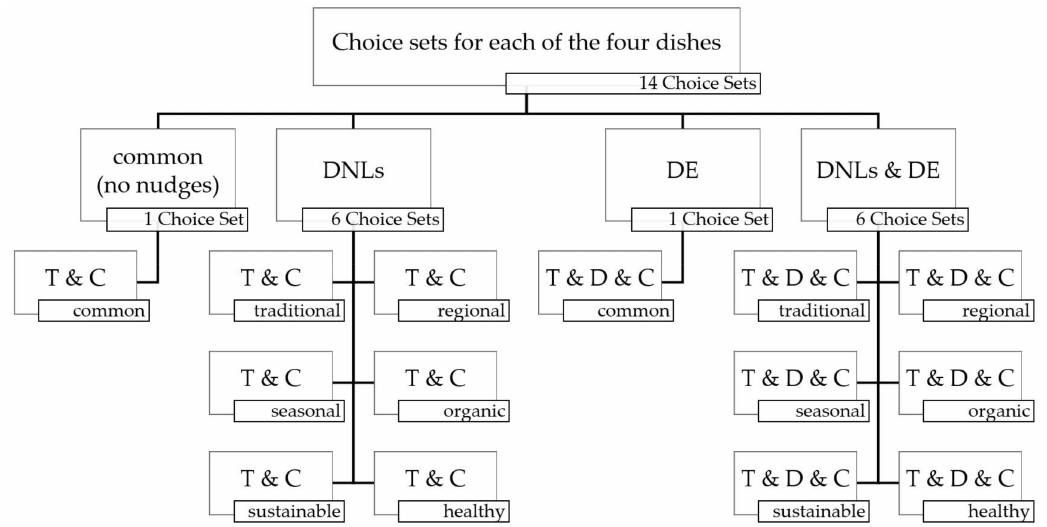
Figure 2. Factorial design to test the combination of DNLs and DE. Note: T = Target Dish (with DNLs), D = Decoy Dish, C = Competitor